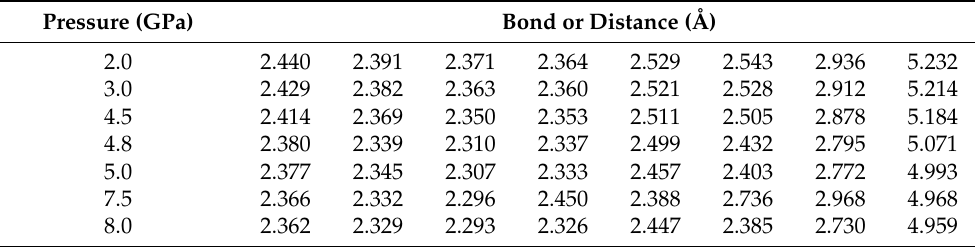
Table 5. Bond lengths (Å) and distance (Å) between Se atoms closest to the iron vacancy of the Fe 3 Se 4 under isotropic external pressure. The atomic numbering scheme is shown in Figure 1a.